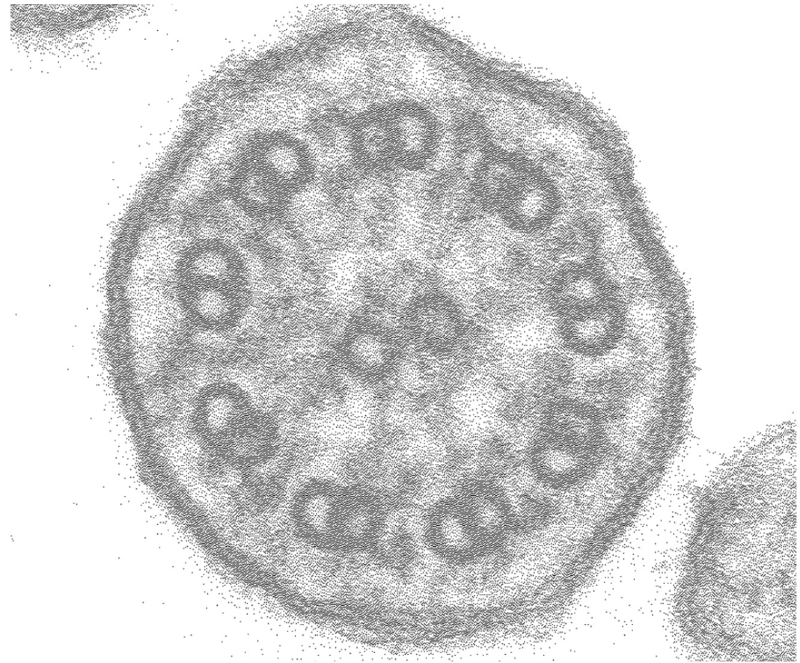
Figure 4. Representative image of electron microscopy. There are no obvious structural abnormalities in nasal cilia.